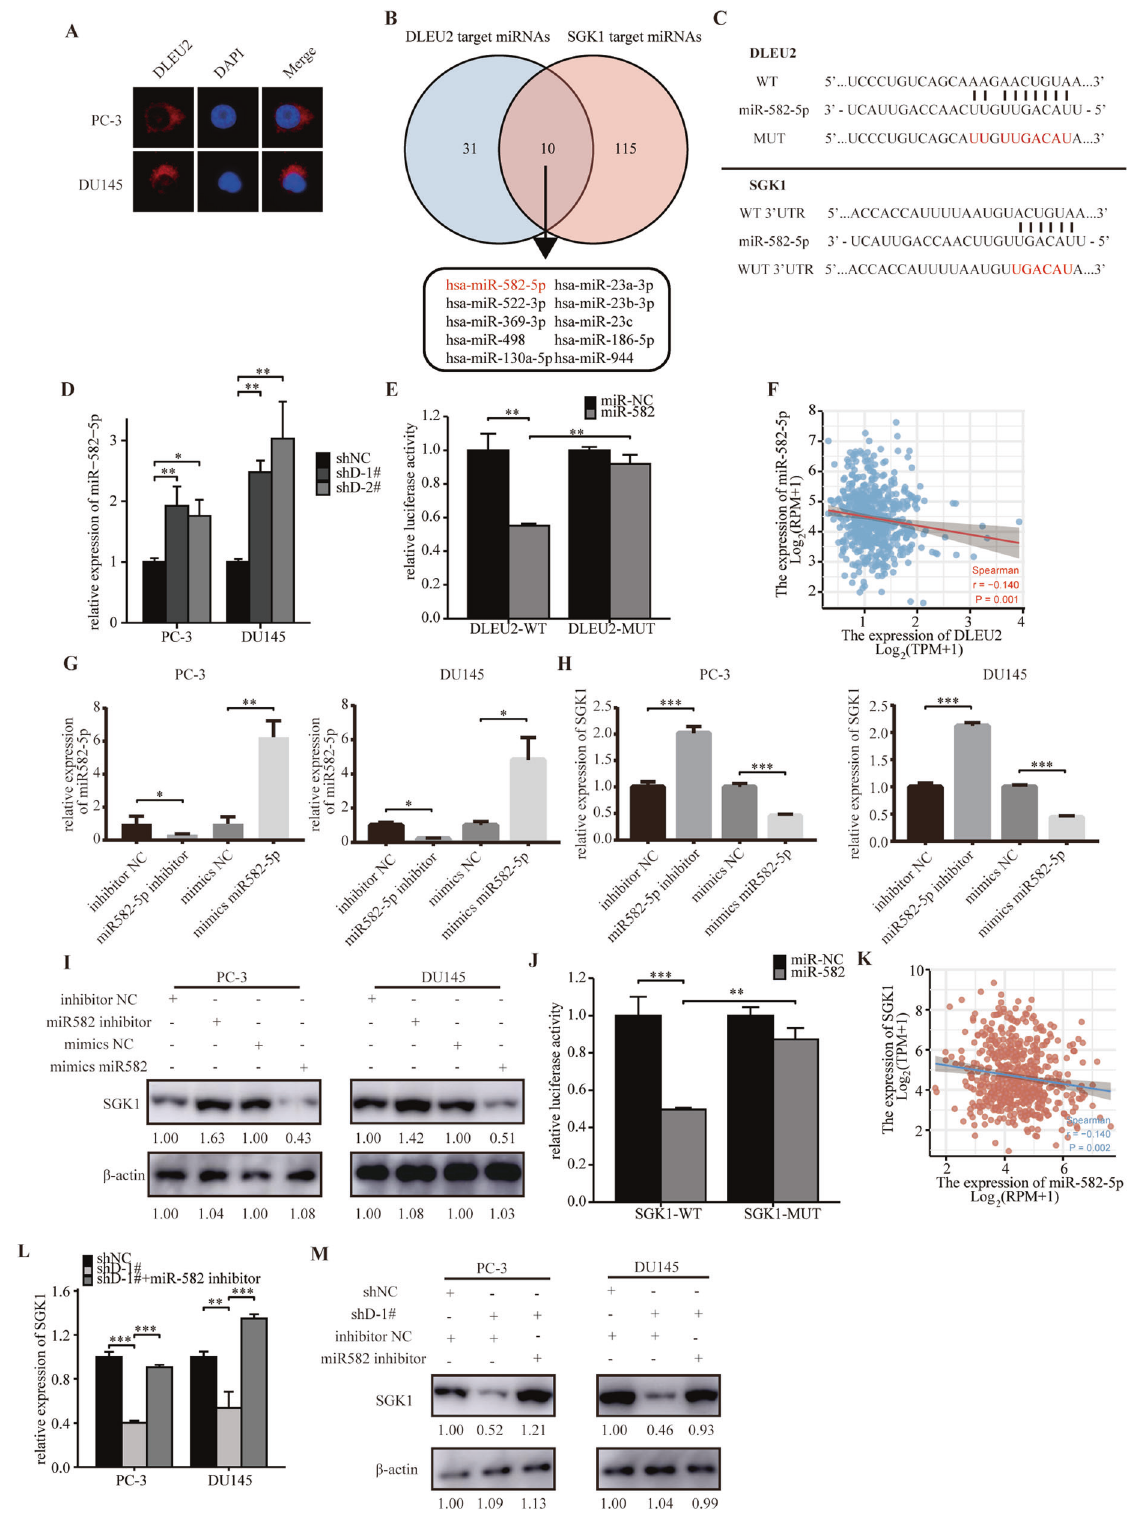
according to univariate and multivariate Cox regression analysis (PFI; P < 0.1; Fig. 1F). Taken together, these results revealed that DLEU2 was highly expressed in advanced prostate cancer and was correlated with poor prognosis.